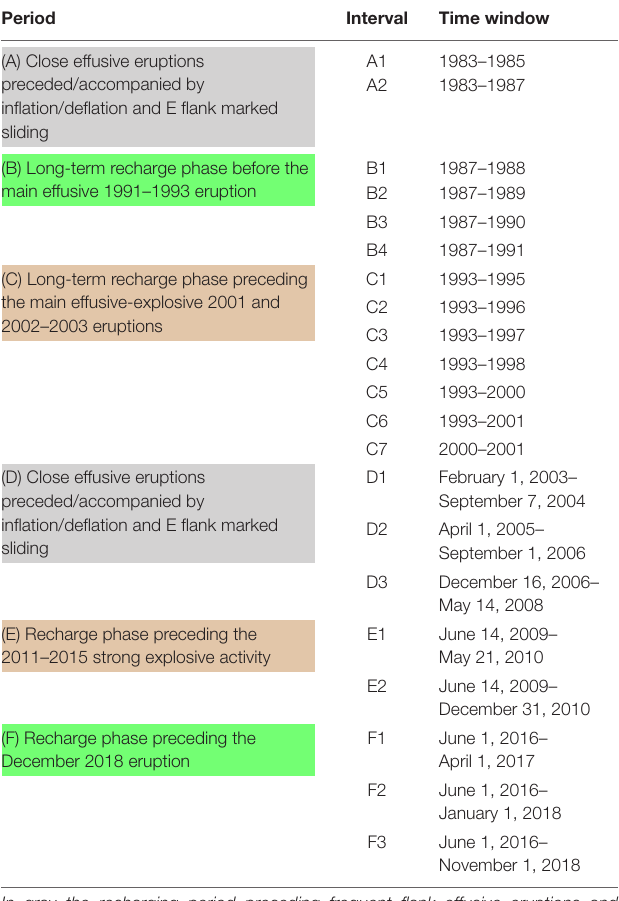
TABLE 2 | Period and interval of the modeled recharge phases. Period